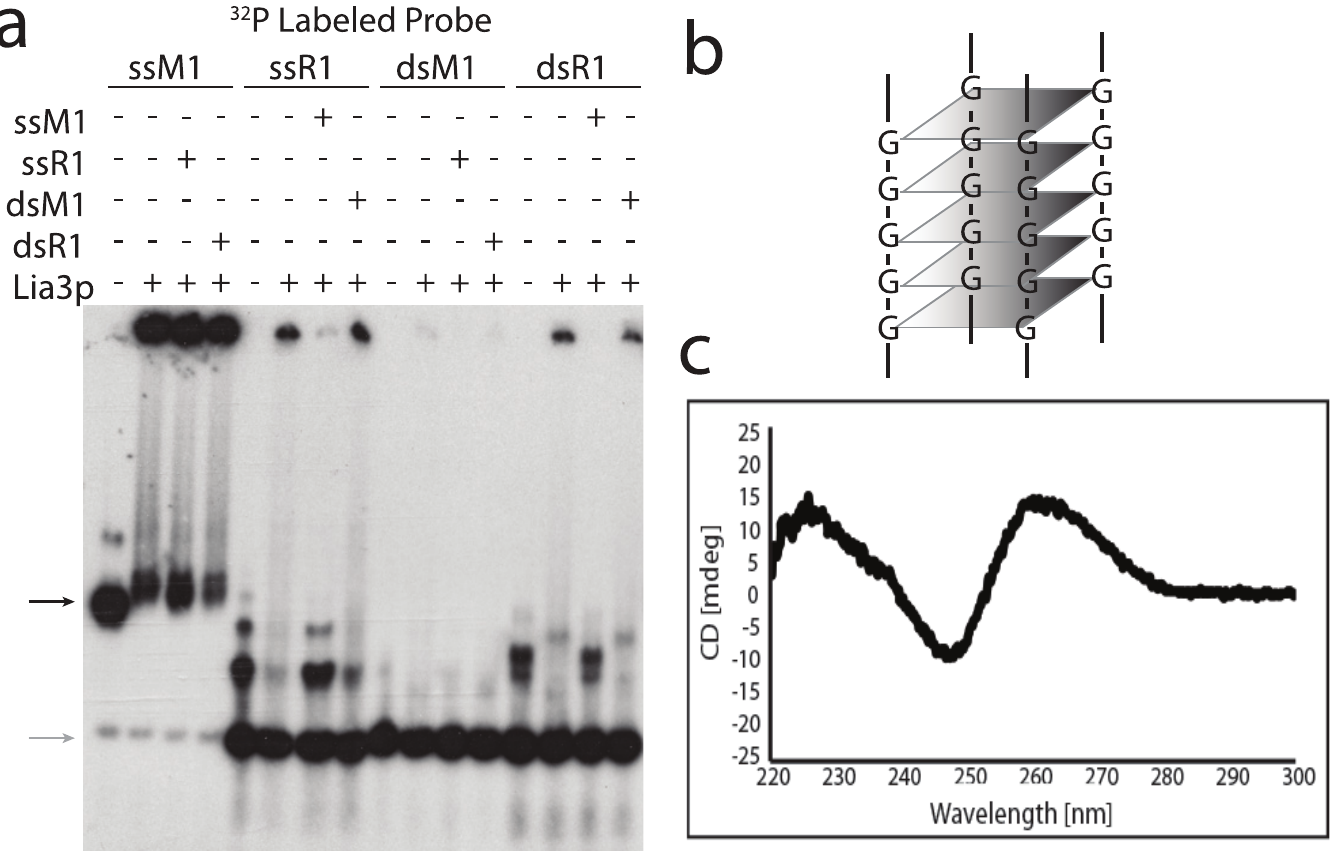
Fig 5. Lia3 binds M IES flanking DNA, which adopts a quadruplex structure. (a) Competition gel shift in which 300 nM His-Lia3 was incubated with 5 times as much unlabeled competitor oligo (listed on the left) followed by incubation with 32 P-labeled oligo (listed above) before loading on a 4% native gel. (b) Schematic representation of a G4 DNA structure. (c) CD spectrum of the M1 oligo in 100 mM KCl buffer.